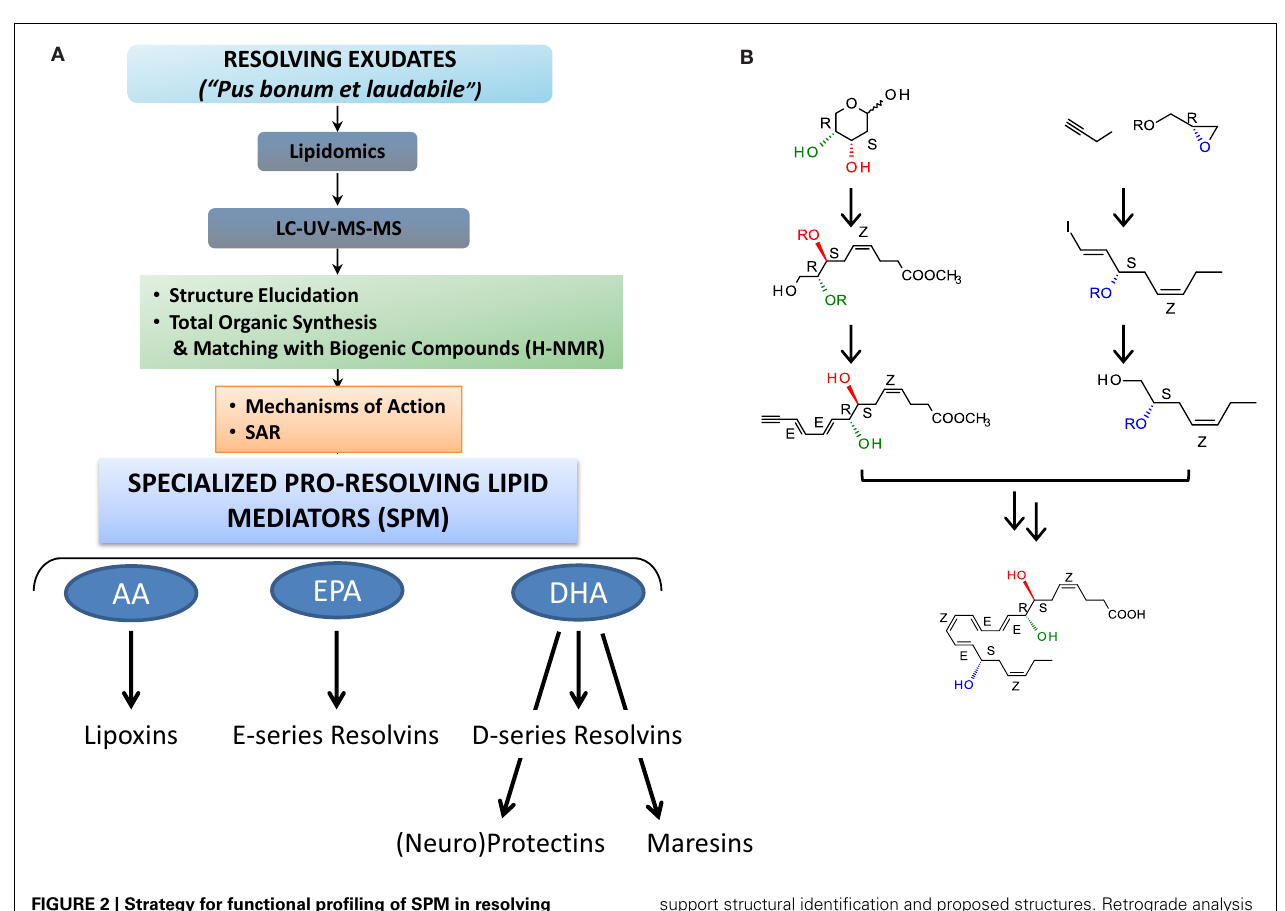
FIGURE 2 | Strategy for functional profiling of SPM in resolving exudates. (A) During self-limited inflammation, murine exudates (a “good and laudable” pus according to ancient physicians; Majno, 1991) as well as human leukocytes biosynthesize SPM, which include the lipoxins, E-series resolvins, D-series resolvins, protectins (neuroprotectin D1), and maresins, which work to keep the inflammatory response within physiological boundaries and help to expedite the return to homeostasis. Functional profiling takes advantage of liquid chromatography-ultraviolet spectrometry-tandem mass spectrometry (LC-UV-MS/MS) for identifying and quantifying SPM. Gas chromatography-mass spectrometry (GC-MS) is also useful to provide additional information together with LC-UV-MS/MS to